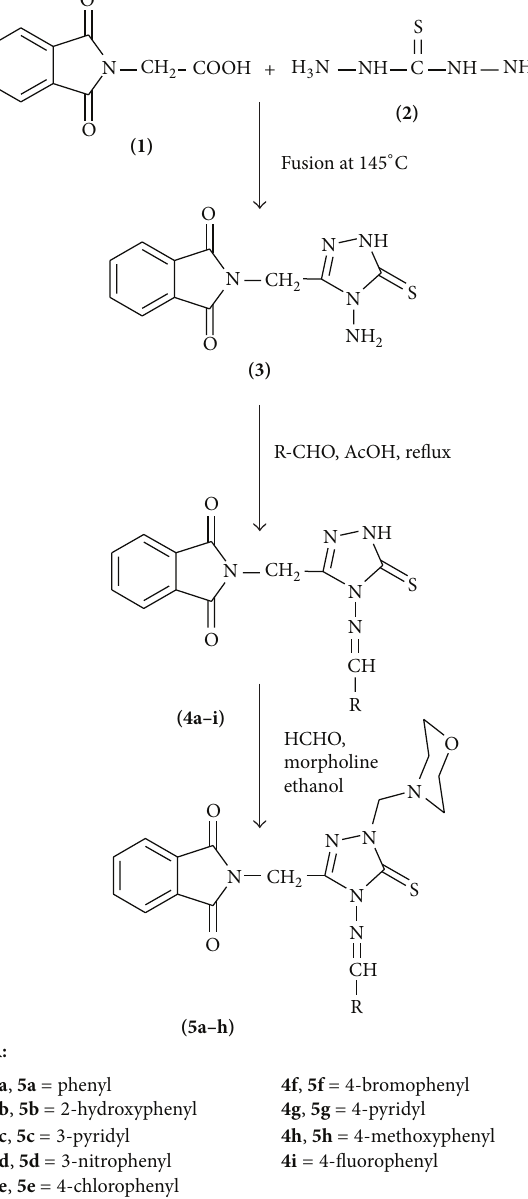
Figure 2: Scheme for the synthesis of ( 5a–5h ). difference of only 0.01–0.03 ppm as in 5d , 5f , and 5g . The